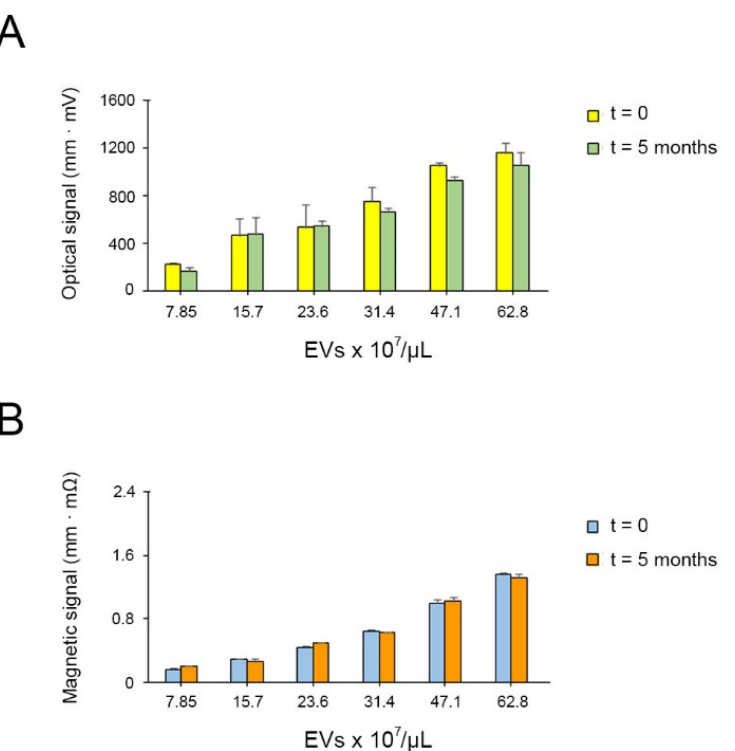
Figure 3. ( A ) Optical signal stability measurements over time. ( B ) Magnetic signal stability meas- urements over